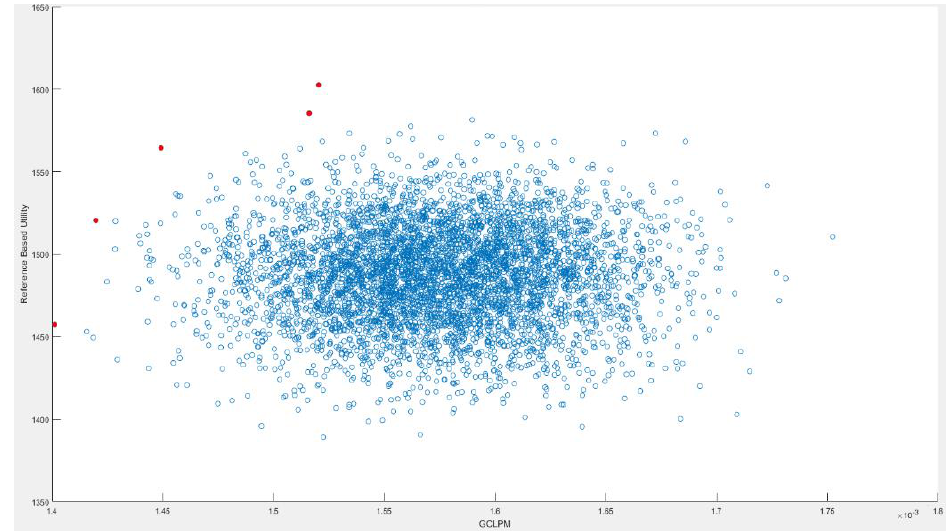
Figure 4. The Result Of Investigation Of 5,000 Different Portfolios In Second Iteration Of Scenario 1